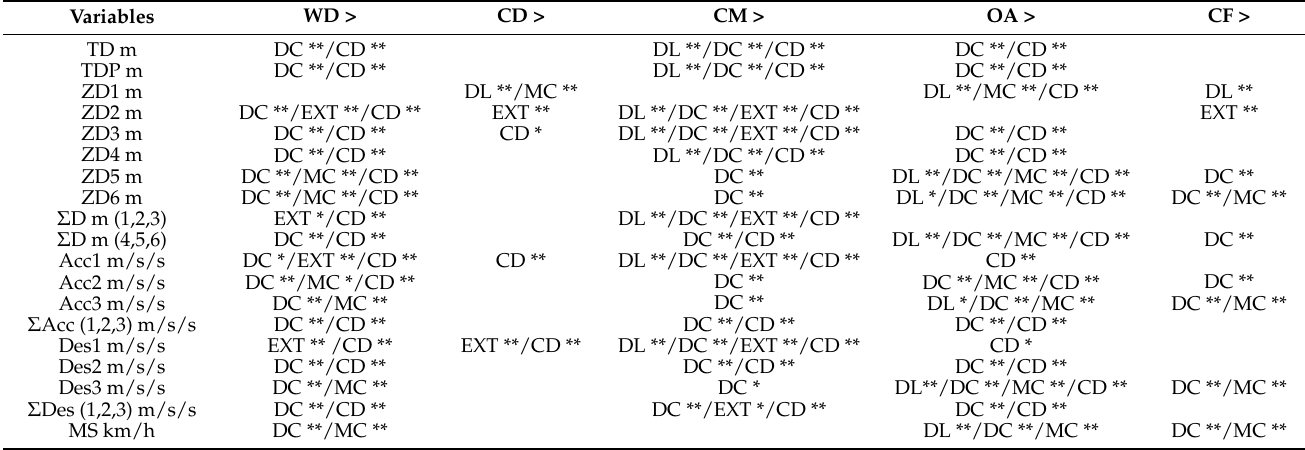
Table 3. Comparisons between playing positions for each of the speed thresholds.